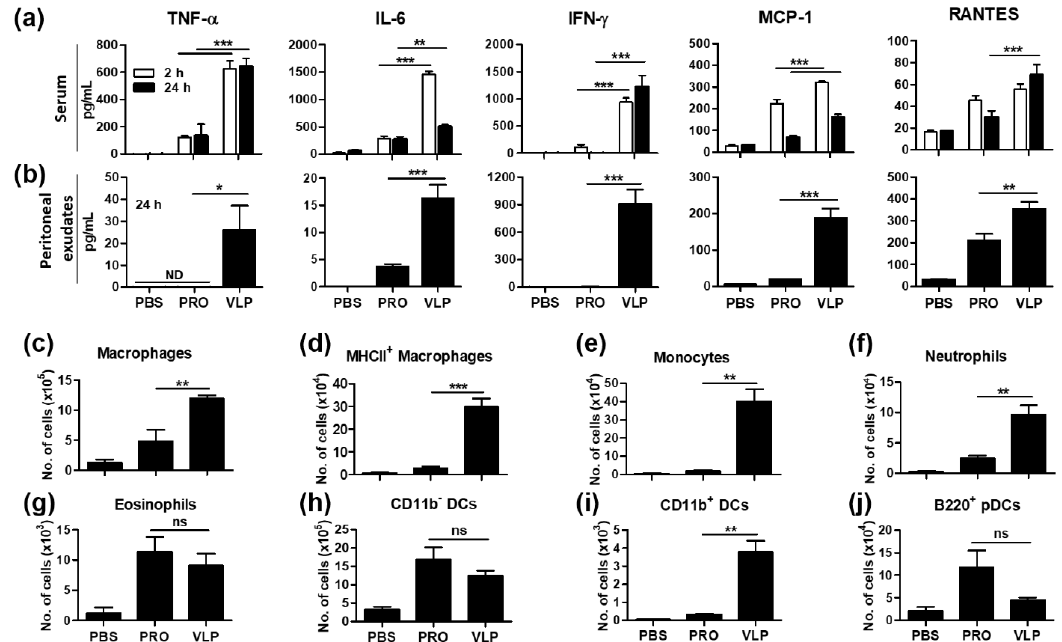
Figure 8. VLP is superior to protein in priming acute innate immune responses in vivo at the injection site. Balb/c mice ( n = 3) were i.p. injected with 200 µ L of PBS, 10 µ g 5xM2e VLP, or 25 µ g 5xM2e protein. The levels of cytokine and chemokine were determined in sera and peritoneal exudates collected at the indicated times. The levels of cytokines (TNF- α , IL-6, IFN- γ ) and chemokines (MCP-1, RANTES) in serum ( a ) and Peritoneal exudates ( b ). ( c – j ) Different phenotypic innate immune cells were determined in the cells collected from peritoneal exudates at 24 h post injection using flow cytometry. PRO: 5xM2e proteins, VLP: 5xM2e VLP. The statistical significance was confirmed by one-way ANOVA and Dunnett’s multiple comparison test. Error bars indicate the means ± SEM of concentrations from individual animals. *; p < 0.05 **; p < 0.01, ***; p < 0.001 indicate statistical significance between